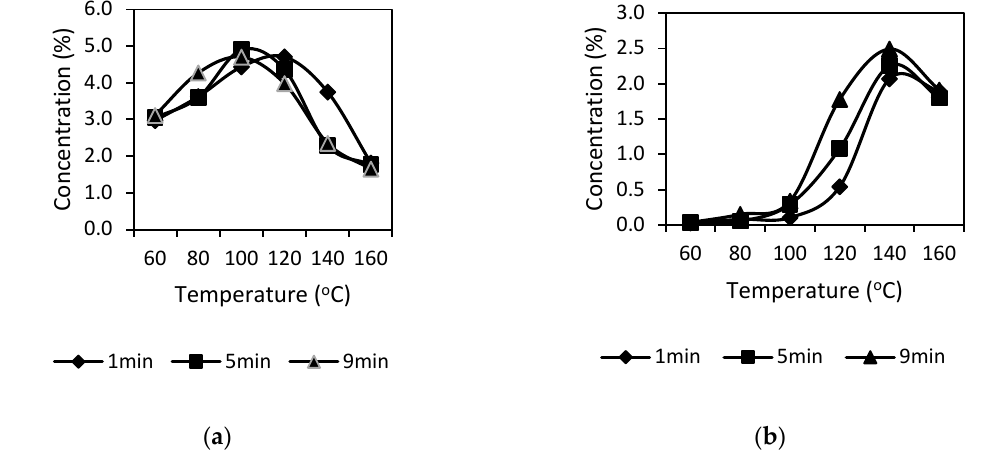
Figure 1. E ff ects of extraction temperature and duration of the SWE method on the yield of ( a ) EGCG and ( b ) GCG.